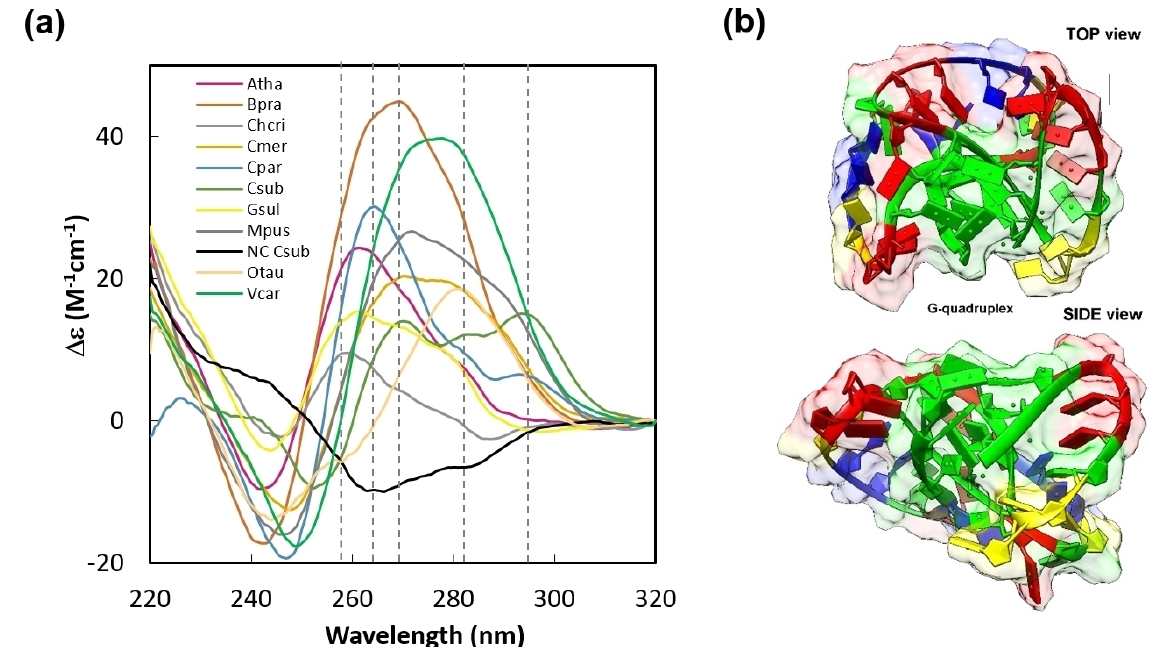
Figure 2. Conformational characterization of conserved G4 locus in the RPB1 gene . ( a ) The differential CD spectra of the putative G4s in the RPB1 gene were calculated as the difference of the CD spectra measured at 20 °C and 90 °C. It can be seen that the negative control is different from all other samples analyzed. It also shows different G4 conformations (4–5 CD bands at approx. 258, 264, 270, 282, and 295 nm—grey vertical dashed lines). Atha— Arabidopsis thaliana ; Bpra— Bathycoccus prasinos ; Chcri— Chondrus crispus ; Cmer— Cyanidioschyzon merolae ; Cpar— Cyanophora paradoxa ; Csub— Coccomyxa subellipsoidea ; Gsul— Galdieria sulphuraria ; Mpus— Micromonas pusilla ; Otau— Ostreococcus tauri ; Vcar— Volvox carteri ; NC—negative control. ( b ) Structural modeling of parallel G4 in Bathycoccus prasinos . The coloring of the nucleotides is default NDB (green for guanines, red for adenines, yellow for cytosines, and blue for thymines). The resulting structure in PDB format can be found in Supplementary Material S4.